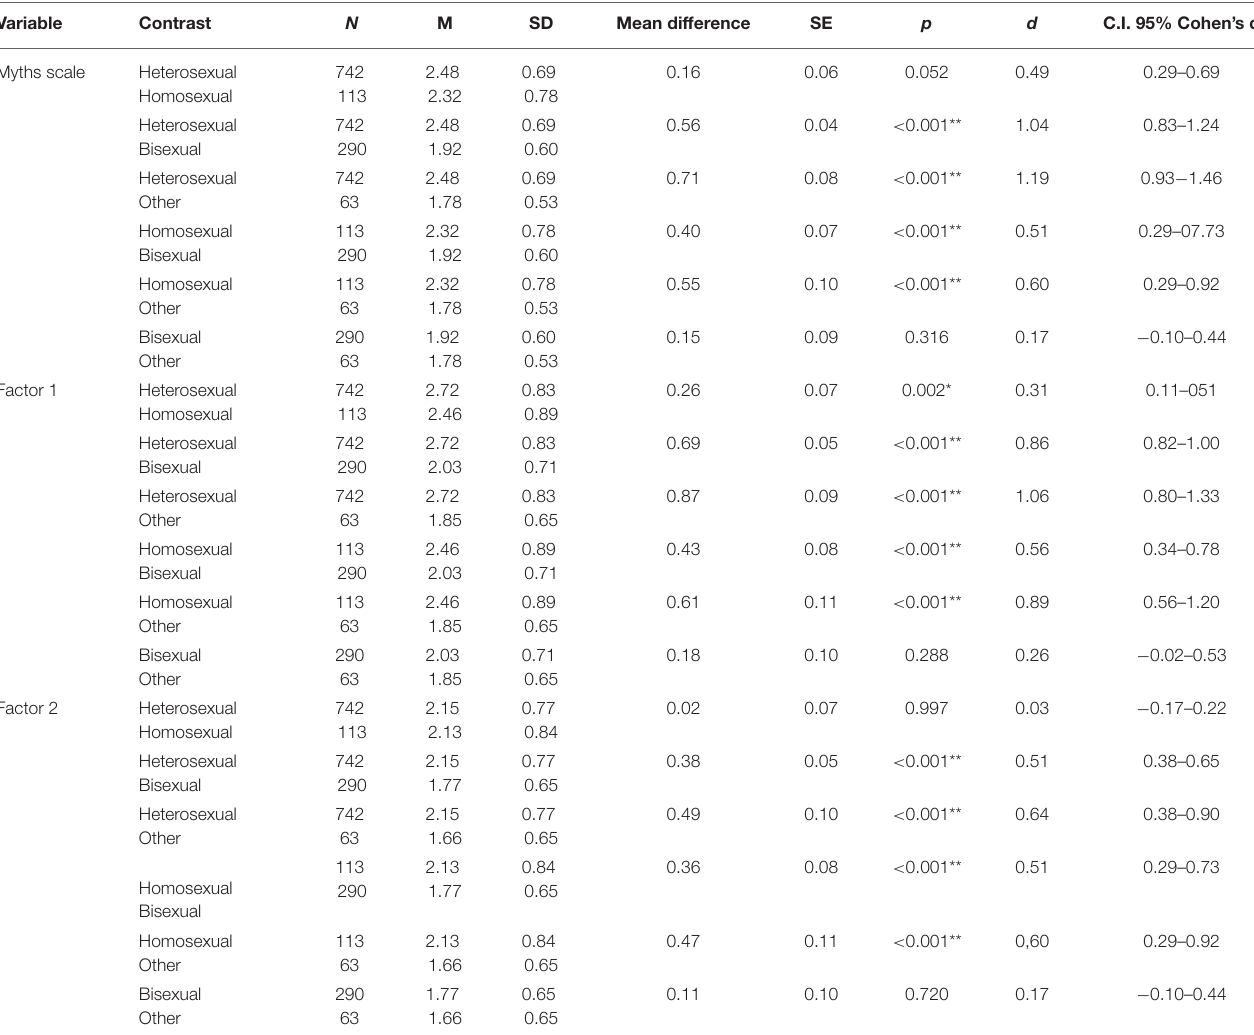
TABLE 5 | Post-hoc factorial ANOVA analysis for the dependent variable of global romantic love myths score and its two factors, considering sexual orientation as a grouping variable. Variable Contrast N M SD Mean difference SE p d C.I. 95% Cohen’s d Myths scale